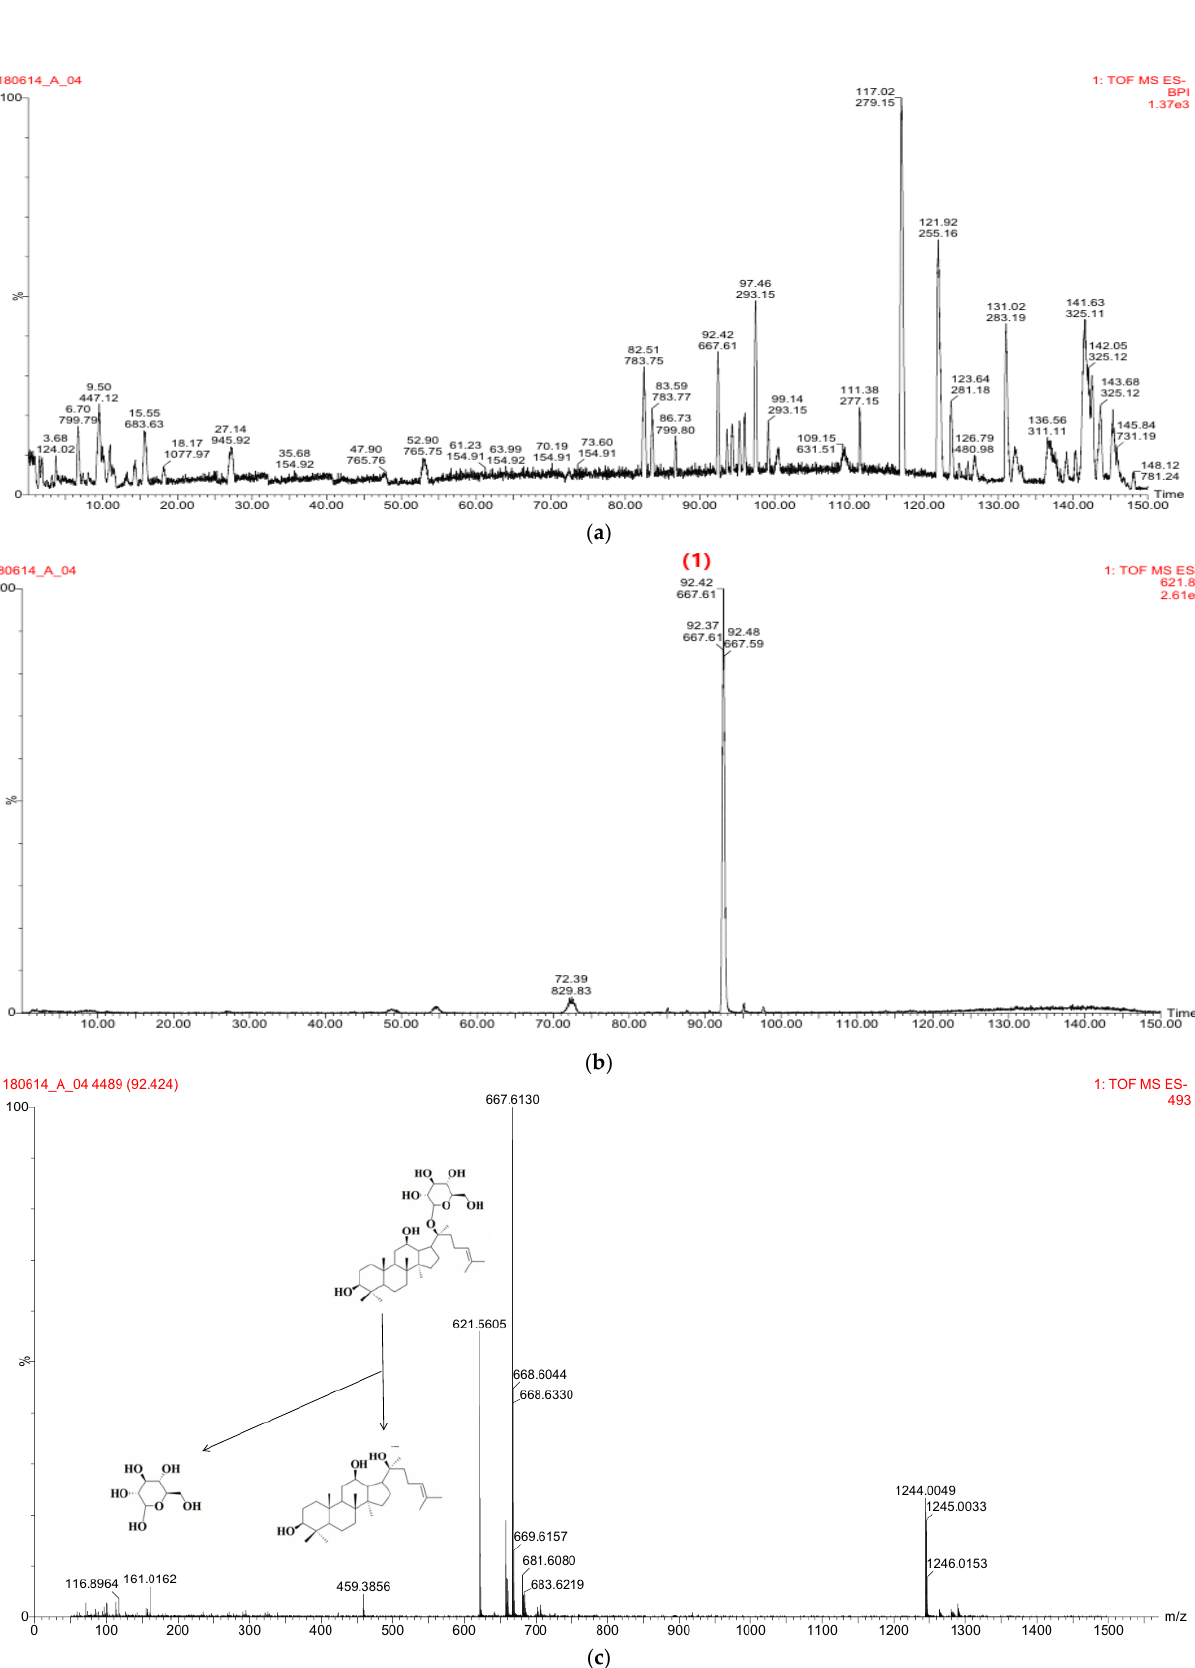
Figure 1. Identification of CK by LC ‐ MS analysis. ( a ) base peak intensity chromatograms of ESI ‐ MS of reactant during enzymatic conversion, ( b ) base peak chromatograms of CK at 92.42 min, ( c ) Structure and mass spectrum of CK derived from ginseng sprout.